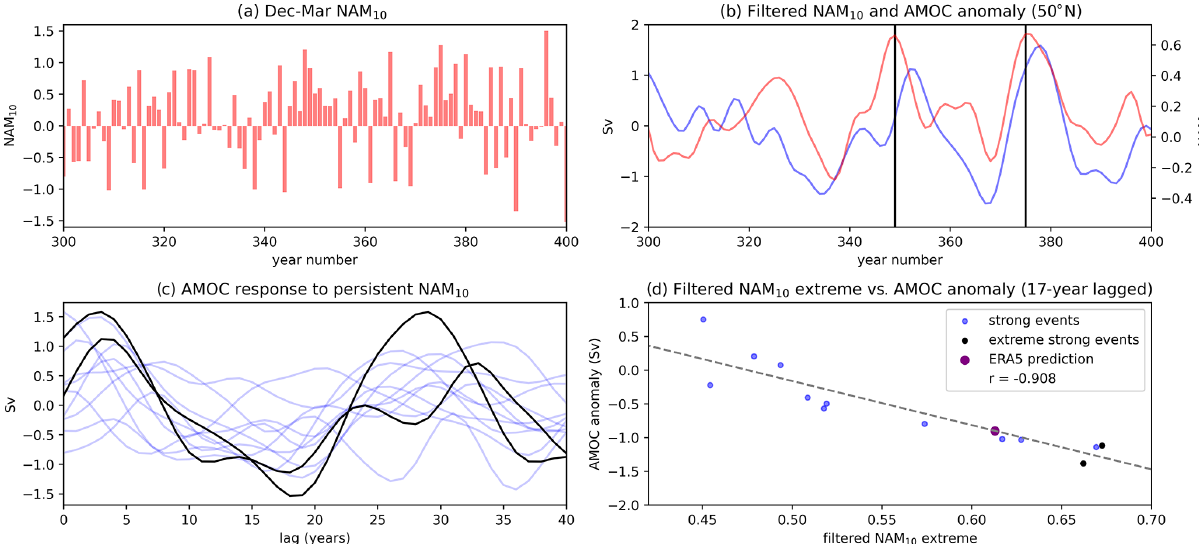
Figure 13. (a) Dec–Mar NAM 10 index (red bars) from the UKESM simulation between year numbers 300 and 400. (b) AMOC (blue) and NAM 10 (red) indices smoothed with the Gaussian filter ( σ = 2 years) between year numbers 300 and 400 of the UKESM simulation. Black vertical lines show the location of the largest smoothed NAM 10 (c) AMOC response to persistent strong NAM 10 intervals. Light blue lines denote lagged AMOC responses of the AMOC from the whole UKESM simulation, and black lines show AMOC responses to NAM 10 intervals marked in (b) by vertical black lines. (d) Scatterplot of filtered NAM 10 index values occurring at persistent strong NAM 10 intervals throughout the whole UKESM simulation ( y axis) against AMOC anomalies at 50 ◦ N lagged 17 years after the persistent intervals’ central year ( x axis). Blue points indicate persistent intervals, and black dots represent the two intervals displayed in panel (b) . The dotted line represents the linear line of the best fit for the points in black and blue. Also included is the 17-year lag AMOC anomaly predicted by projecting the regression coefficients used to construct the linear fit onto the maximum smoothed NAM 10 index in the ERA5 dataset (purple point).